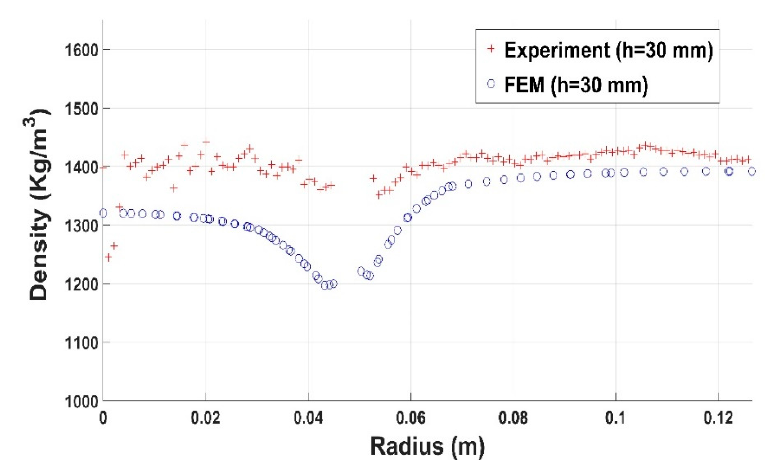
17 of 20 Figure 28. Density profile along the radius (stub hole): experiment vs. finite element result (h = 80 mm).